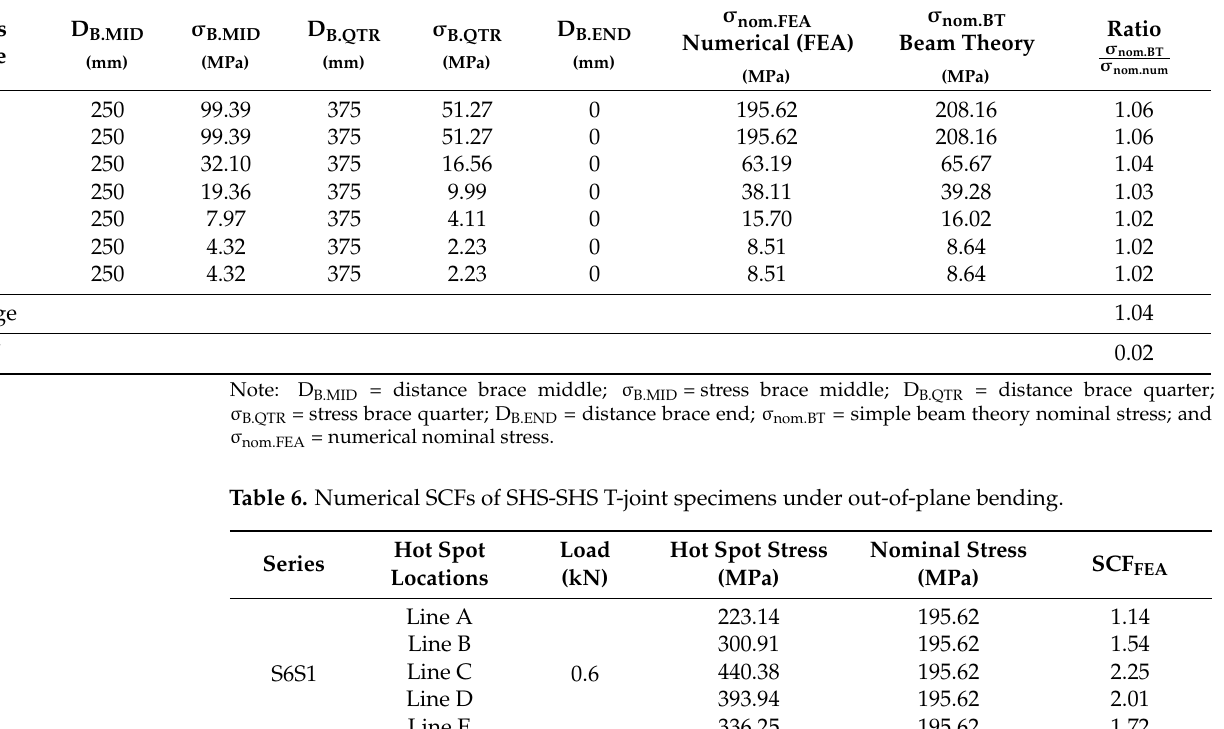
Figure 6. Hot spot locations of a typical FE mesh model. Table 5. Numerical and simple beam theory nominal stresses.